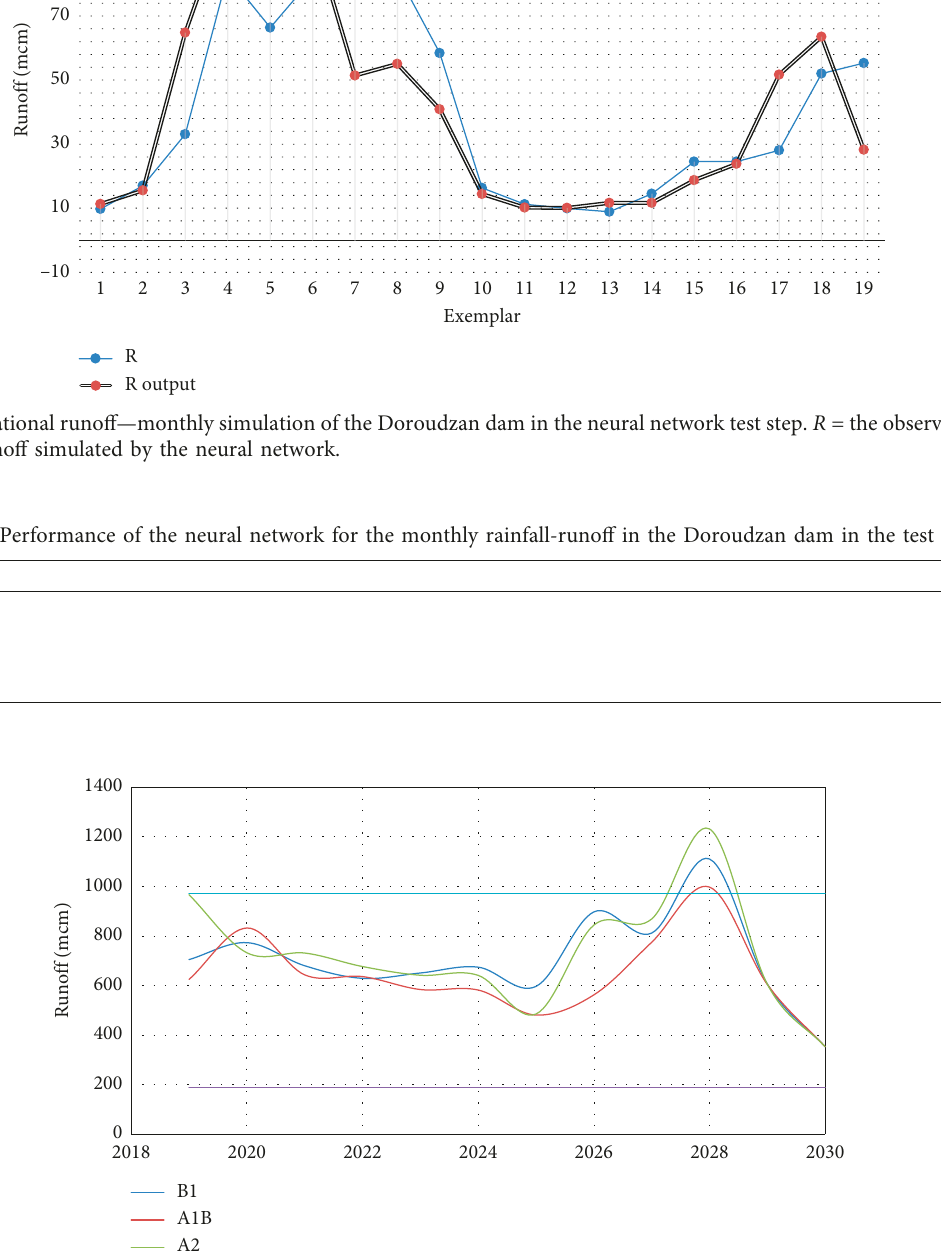
Figure 14: Comparison of the minimum and average observational runoff and the future near period under the ensemble model and the three emission